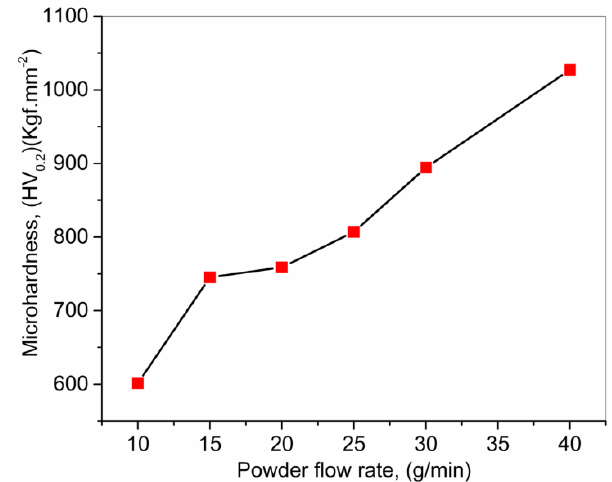
Figure 8. Effect of WC powder flow rate on microhardness; based on the data provided in Ref.